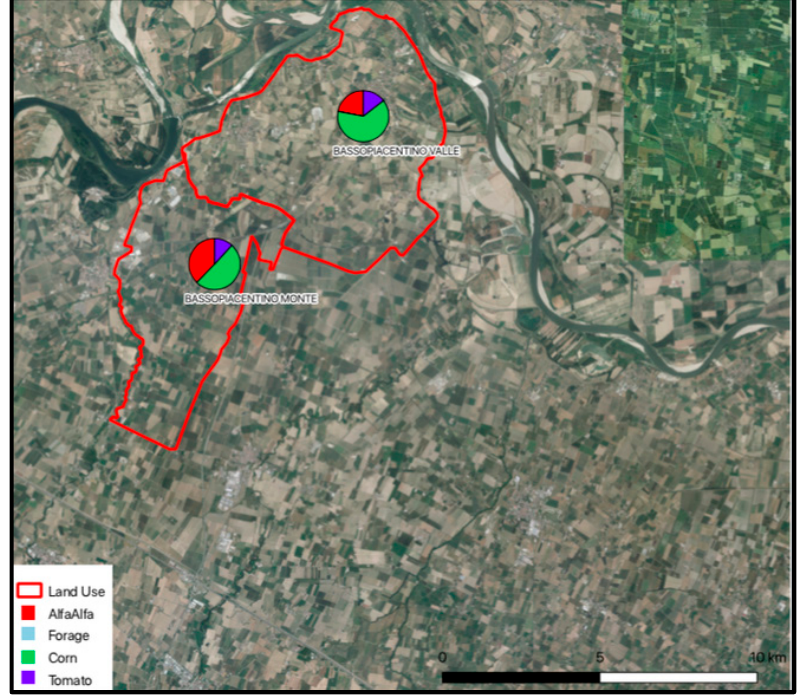
Figure A1. Overview of the two sub-districts for irrigation (north is in the top of the map).